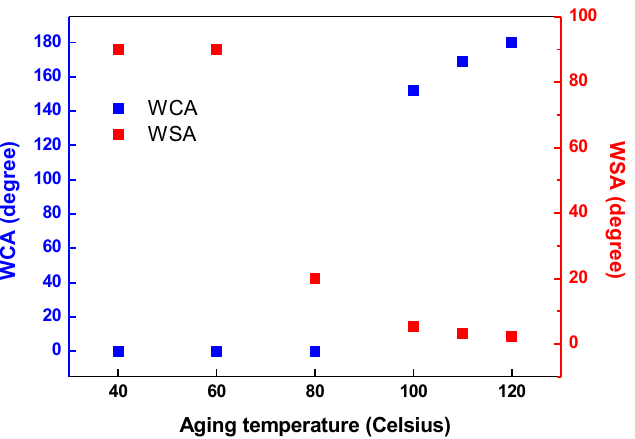
Figure 3. Water contact angle and water shedding angle of the water droplets on the samples that underwent plasma etching for 10 min and thermal aging for 24 h depending at various aging temperatures.